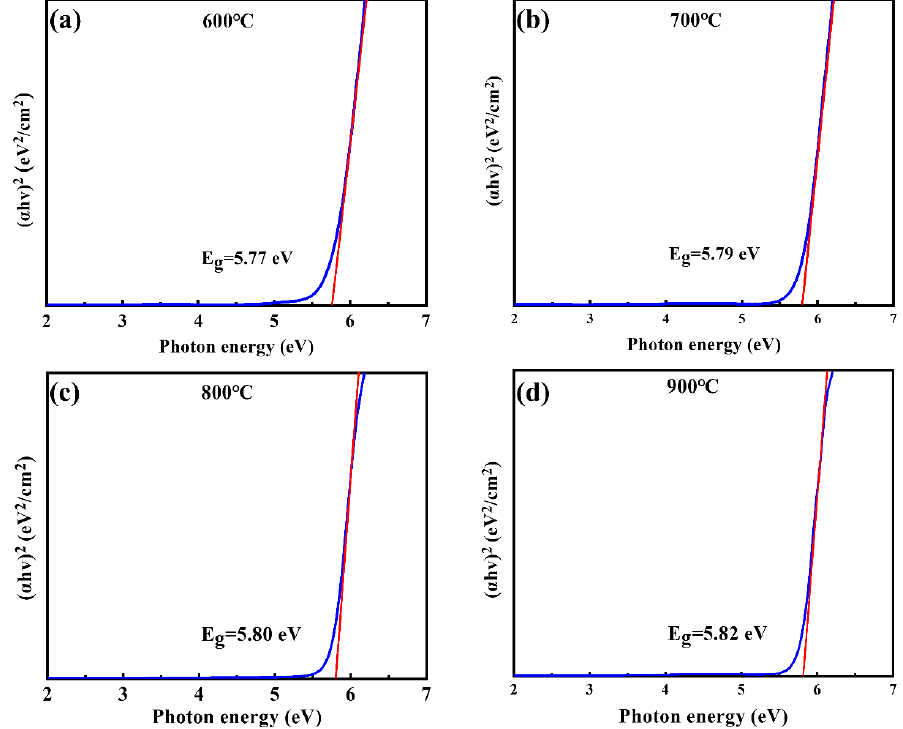
Figure 6. The plot of ( α h ν ) 2 vs. E g for AZO films annealing at different temperatures. ( a – d ) show the